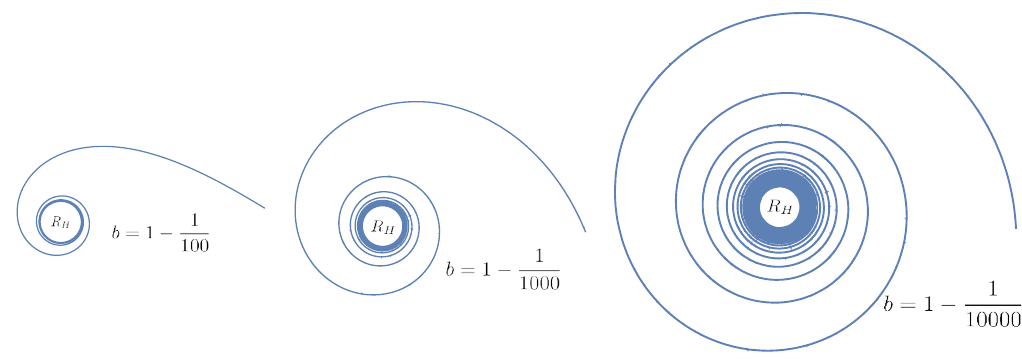
Figure 6 . Trajectories of the b ! 1 (cid:0) null geodesics that account for the Aretakis instability. The angle (cid:8) used in the text co-rotates with the black hole, so we instead use ’ = (cid:8)+ V for these plots, treating ( R; ’ ) as polar coordinates in the plane. The curves begin at a (cid:12)xed R = R 0 > R H and are terminated when the particle enters the horizon at R = R H . The number of orbits scales as 1 = (1 (cid:0) b